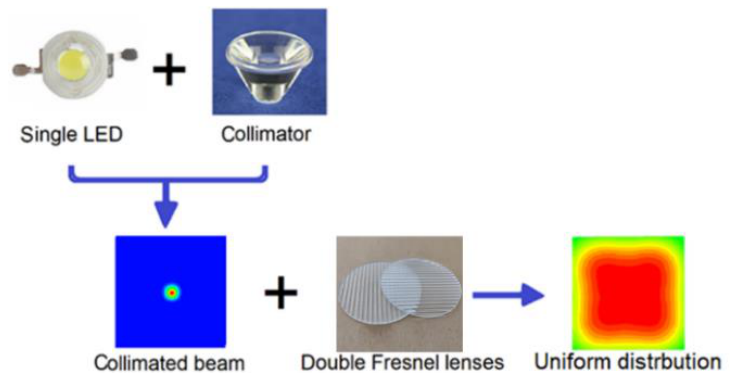
Figure 1. The principle of our proposed uniform LED illumination system.